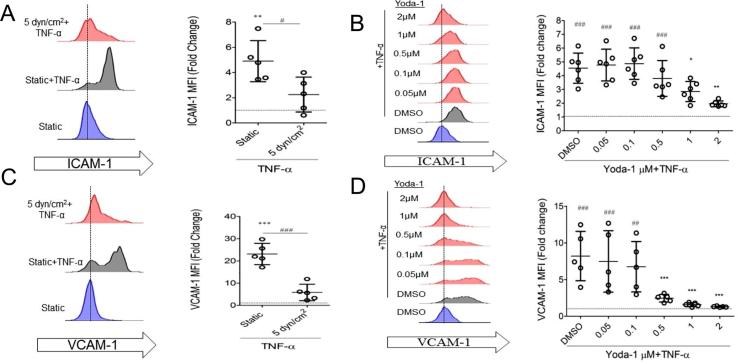
Yoda-1 and shear stress both produce anti-inflammatory phenotypes in endothelium treated with TNF-α. (A–D) Experiments were performed in a similar manner to Fig. 1, but 100 U/mL TNF-α was introduced at the 20 h point for the remaining 4 h. ICAM-1 (A–B) or VCAM-1 (C–D) surface levels quantified (MFI values normalised against their appropriate unstimulated control). (A,C) One-way ANOVA with Tukey’s post-test. *P < 0.01, ##P < 0.001. (B,D) One-way ANOVA with Dunnett’s post test conducted, compared to DMSO (vehicle) control ##P < 0.001 ###P < 0.0001 or TNF-α alone ***P < 0.0001.